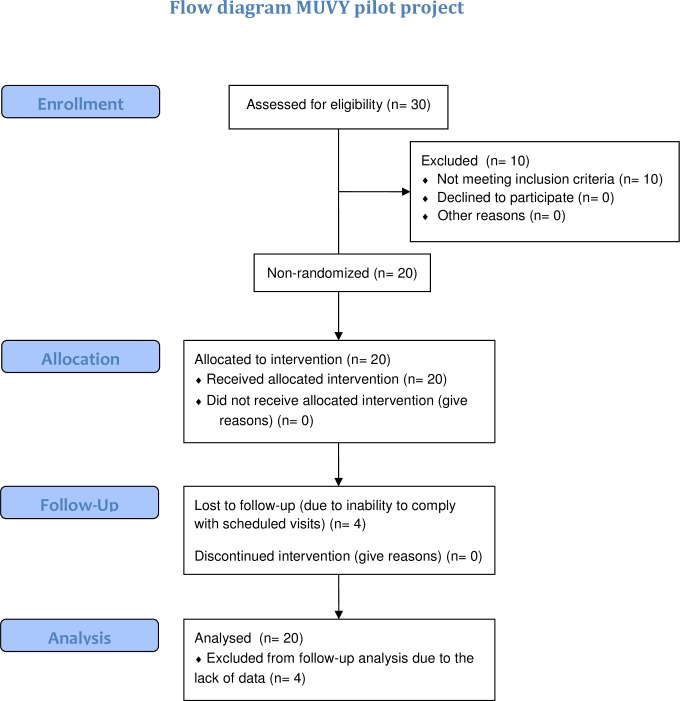
CONSORT flowchart.